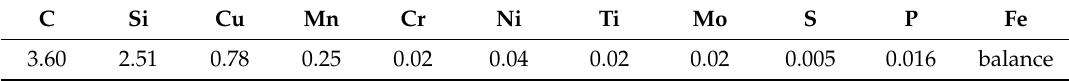
Table 1. Chemical composition of the used ductile cast iron (DCI) grade EN-GJS-700-2